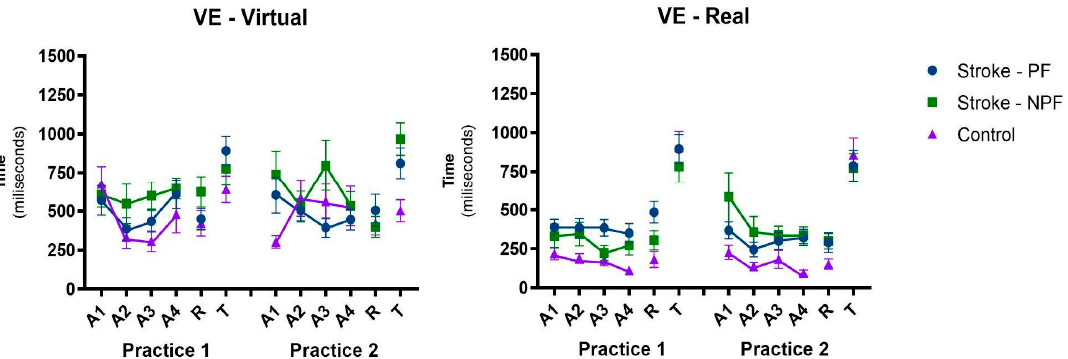
Figure 4. Representation of mean and standard error of the variable error (AE) pattern for blocks, sequences, and groups on interfaces in all phases of the protocol, for stroke and control groups. VE: